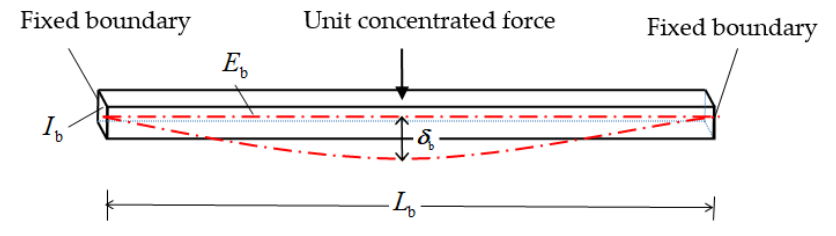
Figure 6. Free-body diagram of the fixed-supported beam.